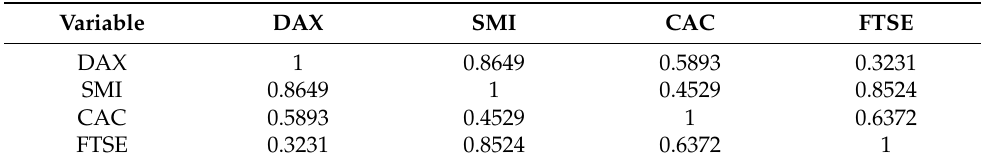
Table A1. Fitted copula parameter ρ for the Gaussian